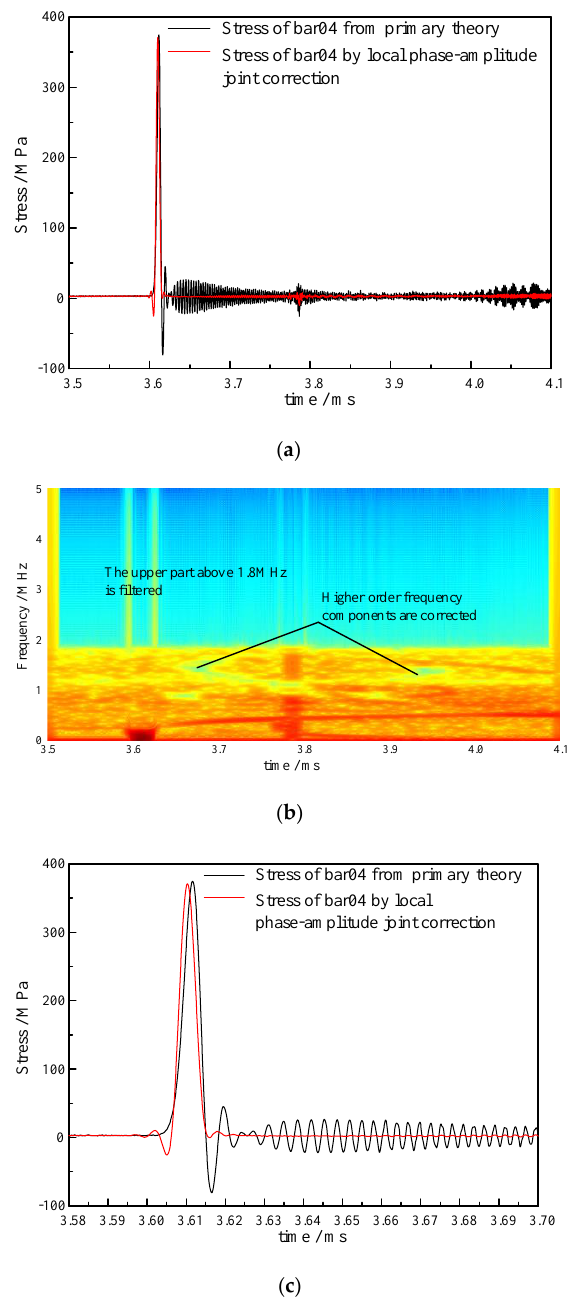
Figure 17. The velocity signal of pressure bar 04 after joint correction of local phase-amplitude from first to third order propagation mode. ( a ) Comparison of corrected stress curve with elementary theory stress curve; ( b ) Time-frequency joint spectrum of corrected stress curve; ( c ) Comparison of stress curves of pressure bar 04 with different methods.